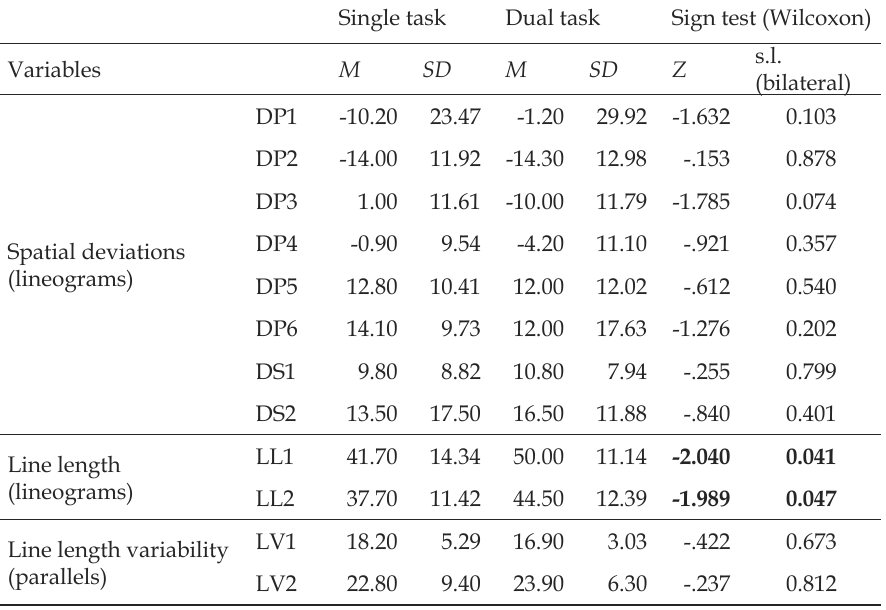
Tab. 1. Descriptive statistics and Wilcoxon sing test results for the difference in the performances between single and dual tasks. Single task Dual task Sign test